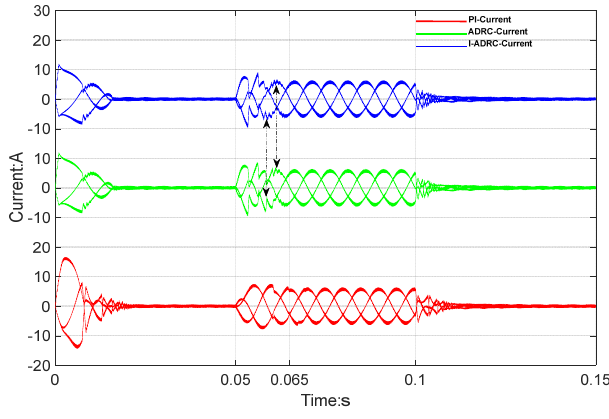
Figure 6. Current simulation curve.